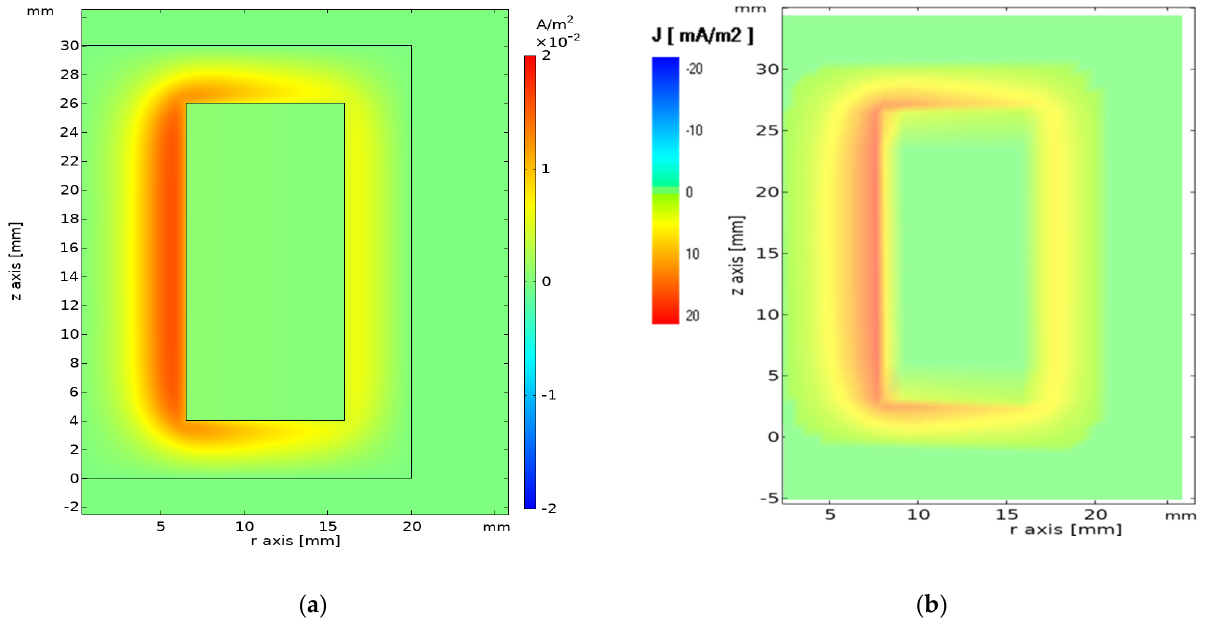
Figure 24. ( a ) Distribution of the displacement current density in the ferrite core at time t = 5 us obtained by Comsol Mutliphysics. ( b ) Distribution of the displacement current density in the ferrite core at time t = 5 us obtained by the proposed approach.